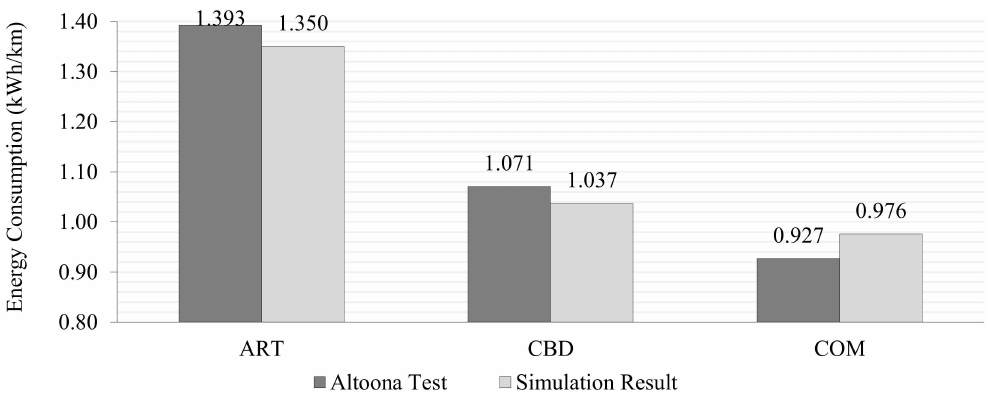
Figure 5. Energy consumption in the Altoona test compared to the developed simulation